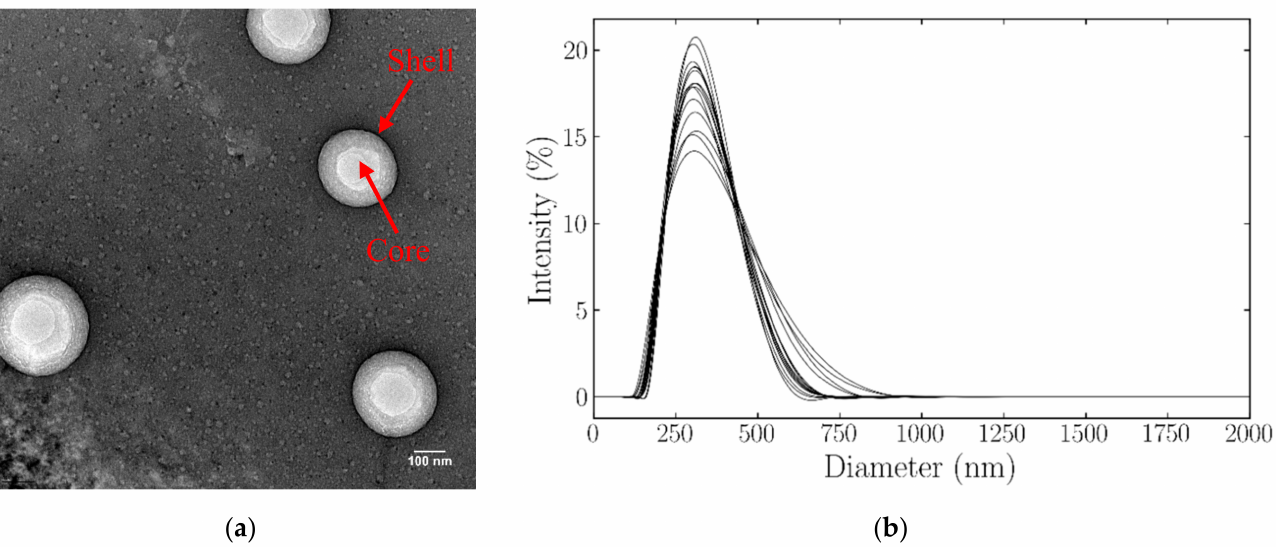
Figure 1. Internal structure and size distribution of BSA-shelled TDFH nanodroplets ( a ) The morphology of BSA-TDFH nan- odroplets visualized on the TEM. Scale bar = 100 nm. ( b ) Size distribution of nanodroplets obtained by DLS